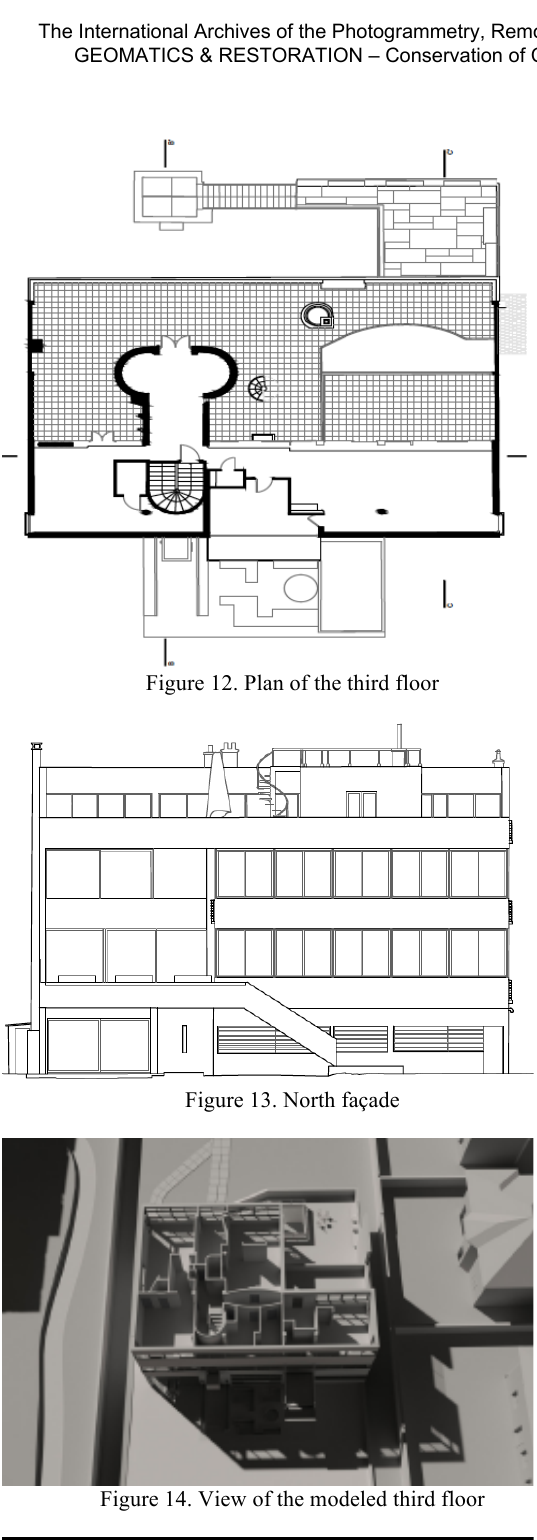
Figure 14. View of the modeled third floor